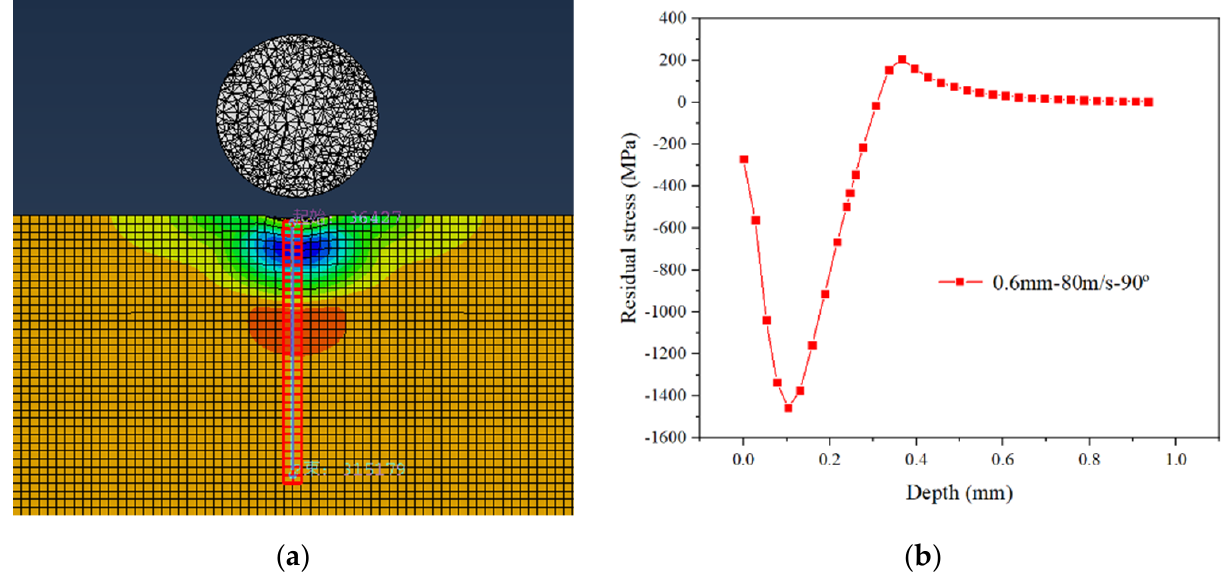
Figure 2. Distribution of residual stress from surface to subsurface of the target. ( a ) Residual stress field; ( b ) residual stress curve.